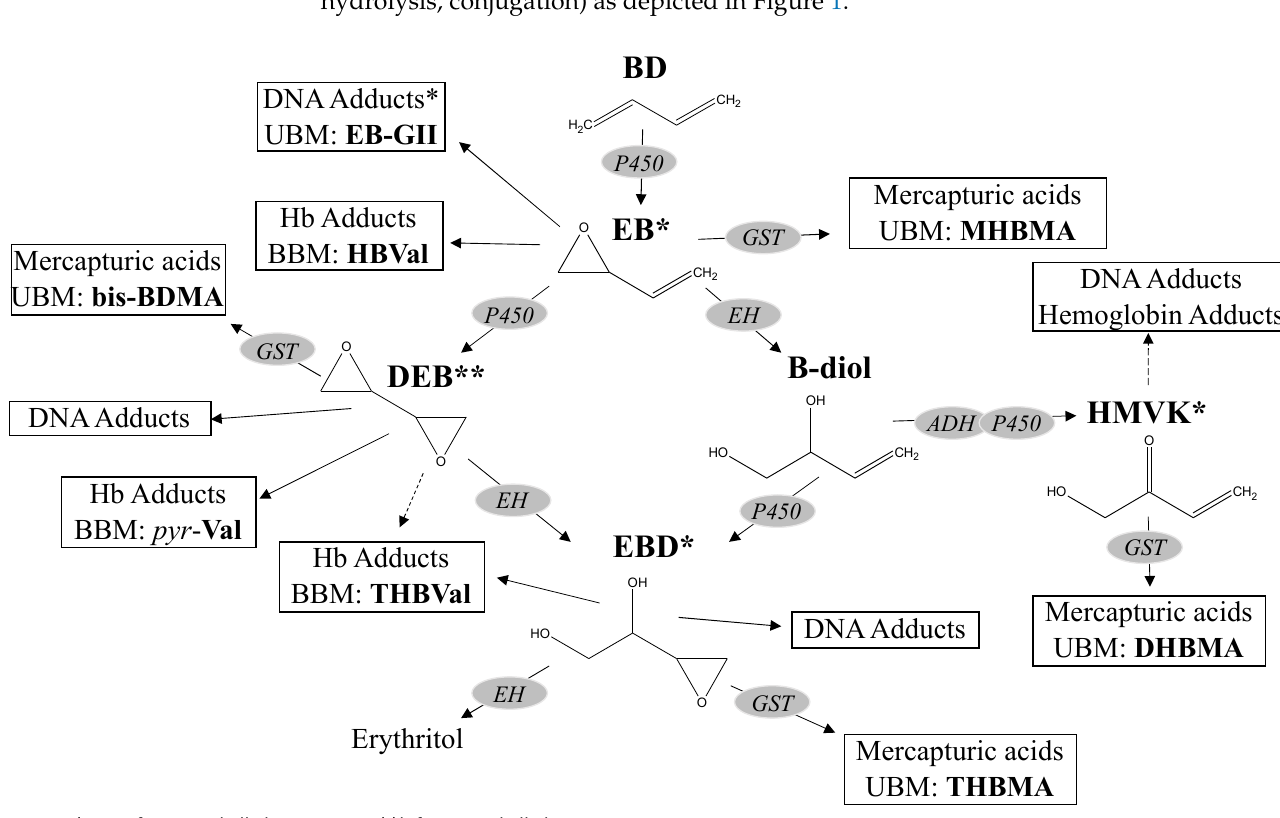
Figure 1. 1,3 ‐ Butadiene metabolism. Figure 1. 1,3-Butadiene